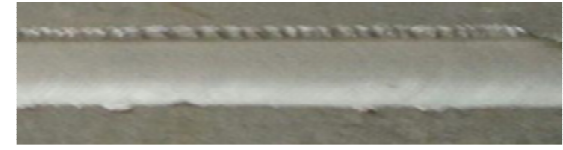
Fig. 7. Minimizing the flash defect (BT-2) .